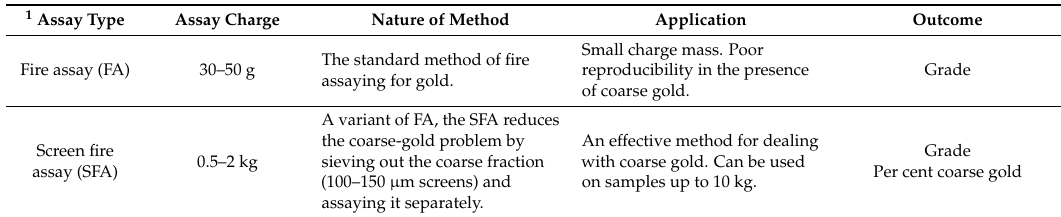
Table 19. Summary of gold assay